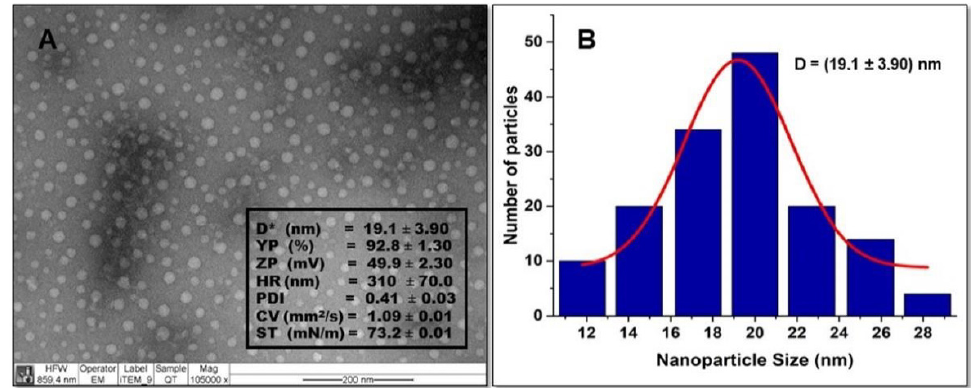
Figure 1. ( A ) Transmission electron microscopy (TEM) of NQo. Physicochemical characterization parameters: D*, diameter (nm); YP, yield particle (%); ZP, Zeta potential (mV); HR, hydrodynamic radius (nm); PDI, polydispersity index; CV, cinematic viscosity (mm 2 / s); ST, surface tension (mN / m). ( B ) Histogram showing the NQo size distribution.